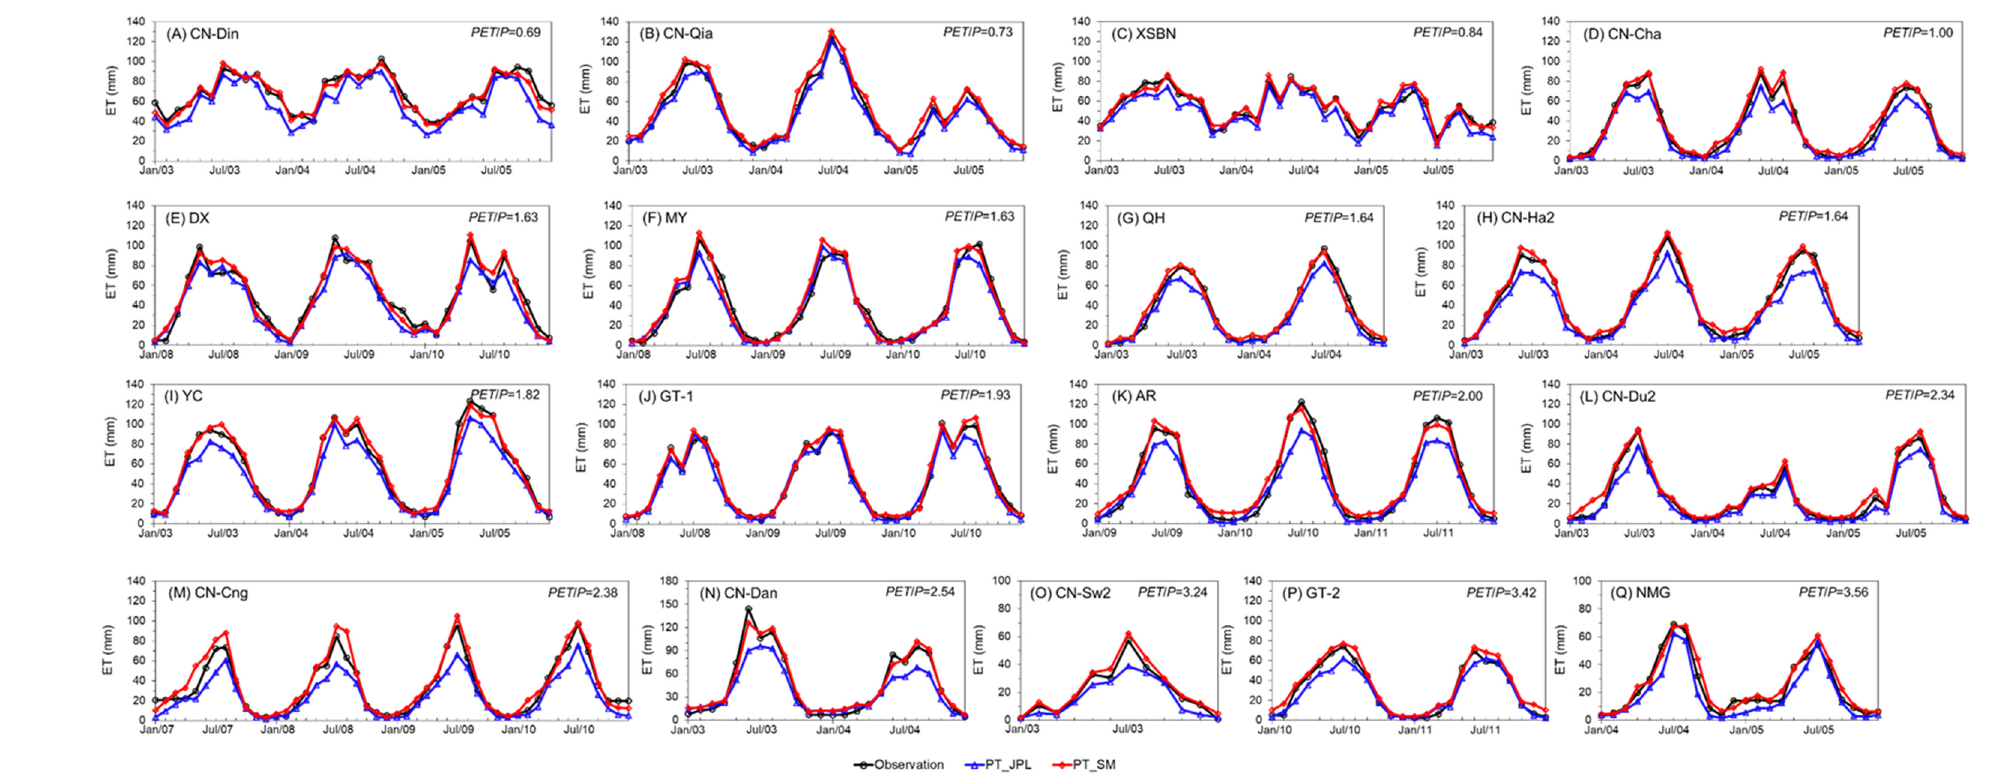
Figure 6. In situ model performance across 17 eddy covariance sites (( A ): CN–Din; ( B ): CN–Qia; ( C ): XSBN; ( D ): CN–Cha; ( E ): DX; ( F ): MY; ( G ): QH; ( H ): CN–Ha2; ( I ): YC; ( J ): GT–1; ( K ): AR; ( L ): CN–Du2; ( M ): CN–Cng; ( N ): CN–Dan; ( O ): CN–Sw2; ( P ): GT–2; ( Q ): NMG) distributed across China.